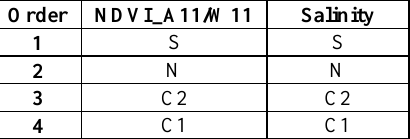
Figure 9. Correlation between the average NDVI_W11 and groundwater salinity values for Classe AOIs Order NDVI_A11/W11 Salinity